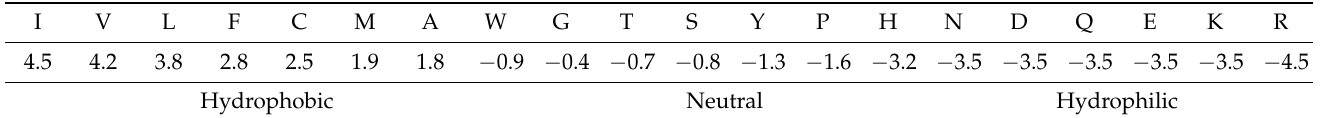
Table 2. According to the Kyte-Doolittle scale (J. Mol. Biol. 1982), there are three IMGT ‘hydropathy’ classes [29]. Amino acids in each class are ordered from the most hydrophobic on the left-hand side (i.e., I) to the most hydrophilic on the right-hand side (i.e., R) [29]. Abbreviations: A, alanine; R, arginine; N, asparagine; D, aspartic acid; C, cysteine; Q, glutamine; E, glutamic acid; G, glycine; H, histidine; I, isoleucine; L, leucine; K, lysine; M, methionine; F, phenylalanine; P, proline; S, serine; T, threonine; W, tryptophan; Y, tyrosine; V, valine.